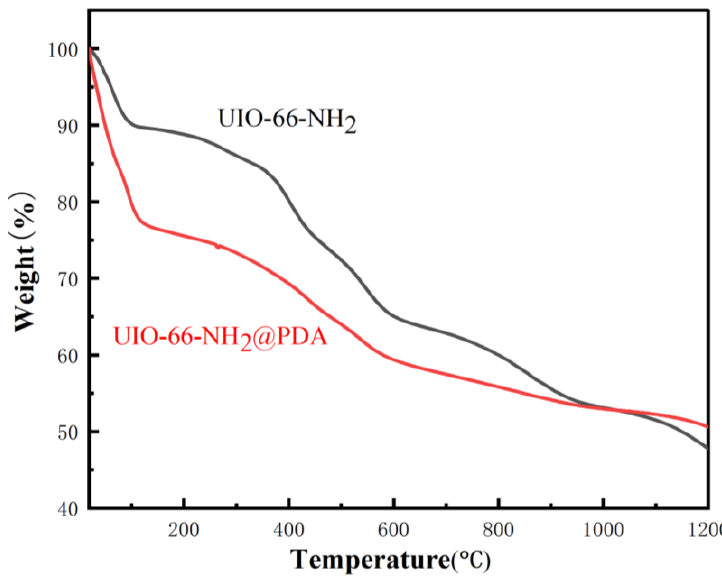
Figure 4. TGA curves of pure UiO-66-NH 2 and UiO-66-NH 2 @PDA.